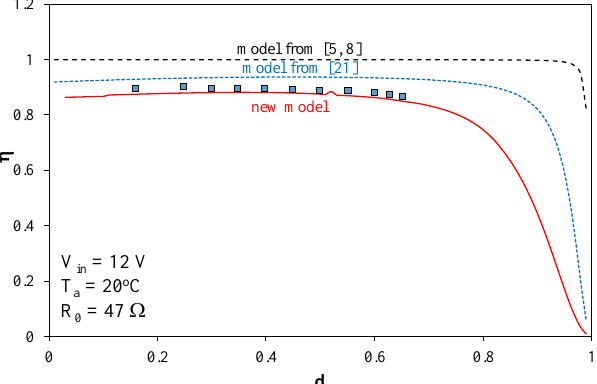
Figure 12. Computed and measured dependences of boost converter output voltage on duty cycle.